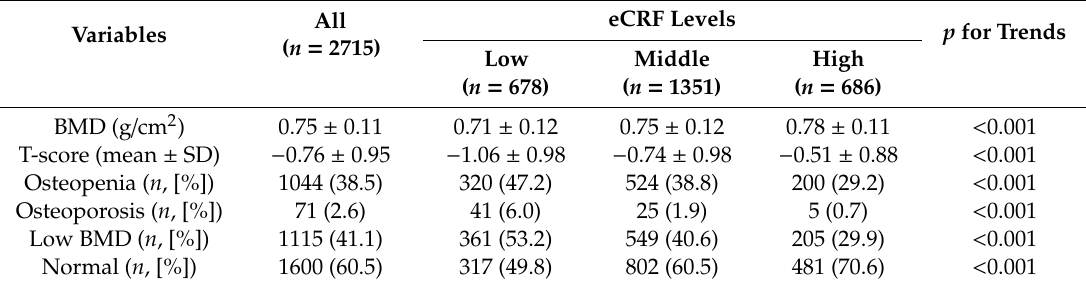
eCRF: estimated cardiorespiratory fitness; osteopenia is defined as a T-score of − 1.0 or less and greater than − 2.5, and osteoporosis is defined as a T-score of − 2.5 or less; low BMD includes both osteopenia and osteoporosis; the